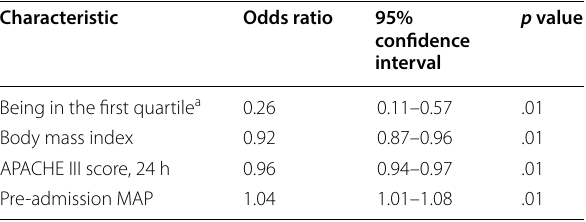
APACHE acute physiology, age, chronic health evaluation, MAP mean arterial pressure a Patients had ΔMAP values in the lowest quartile